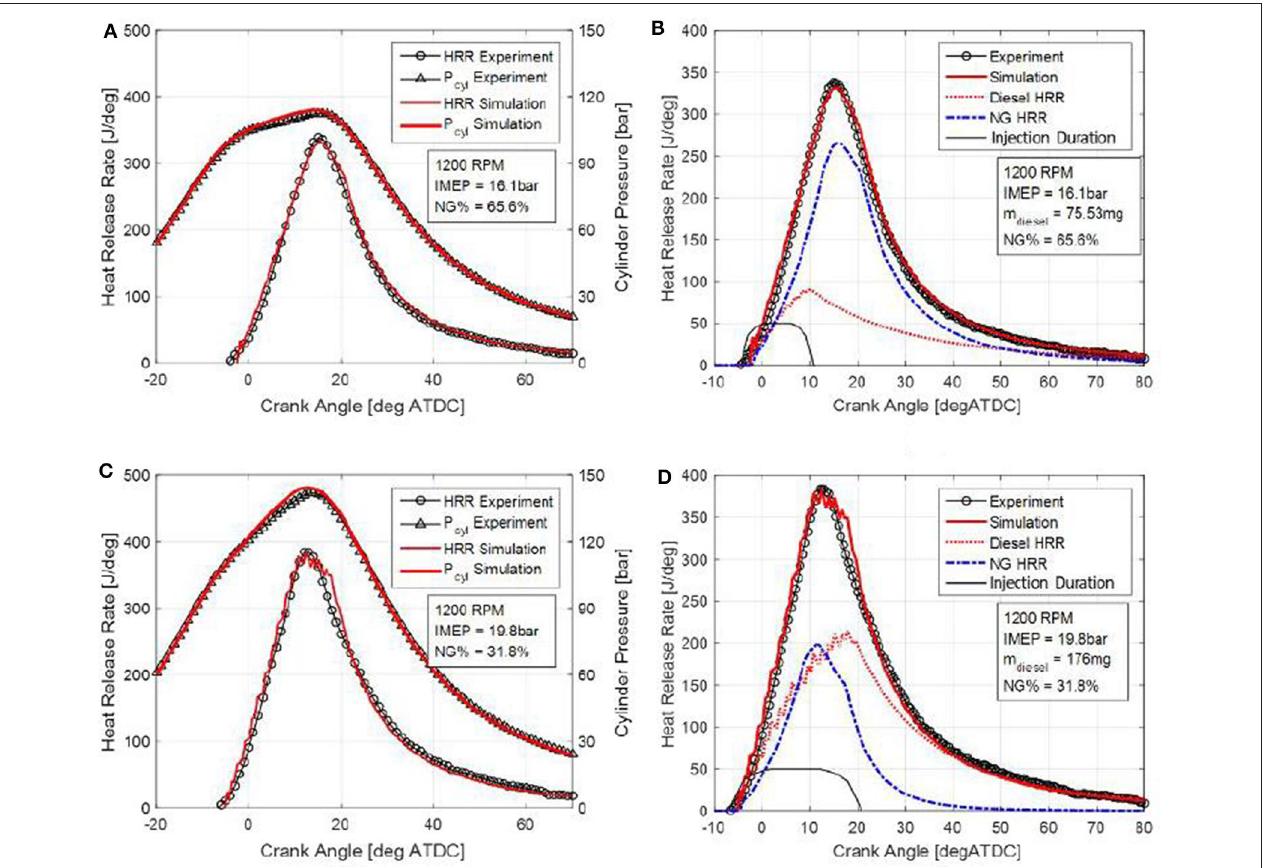
FIGURE 13 | (A–D) Validation results of heat release profile and cylinder pressure at dual-fuel operation